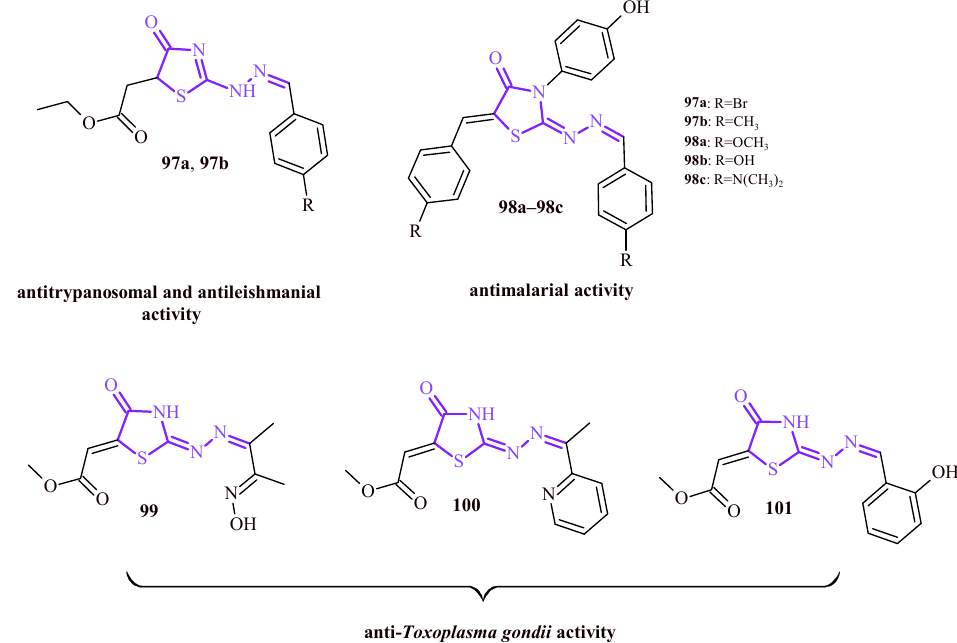
Figure 43. The 2-ylidenehydrazinylidenethiazolidin-4-one derivatives with antiparasitic activities.